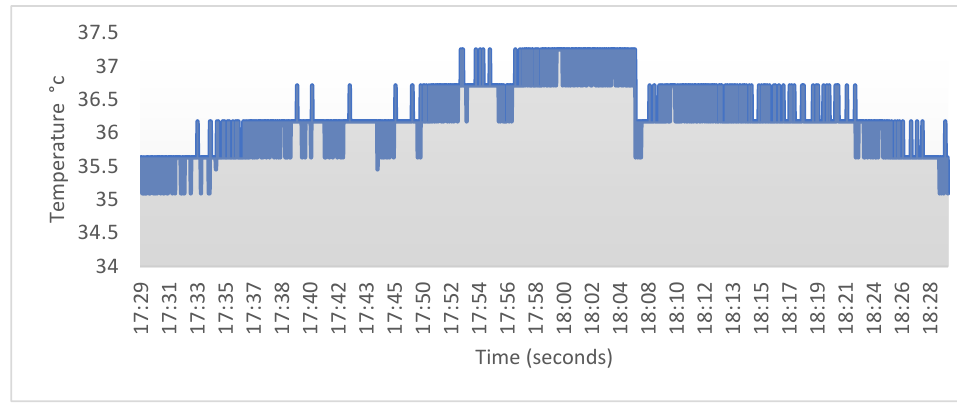
Figure 9. Evening Temperature signal .